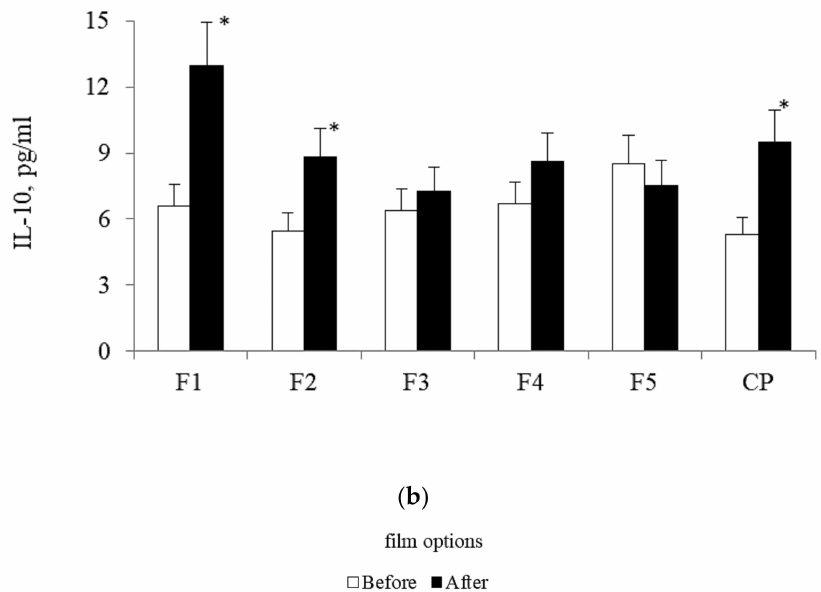
Figure 6. The concentration of IL-6 ( a ) and IL-10 ( b ) in the cultural filtrates on the 6th day of cultivation on PHAs-films before (Before) and after (After) stenting.CP—cultural plastic. F1–F5—PHA-films. *—The values for the variant after stenting, significantly di ff erent from the variant before stenting ( p <